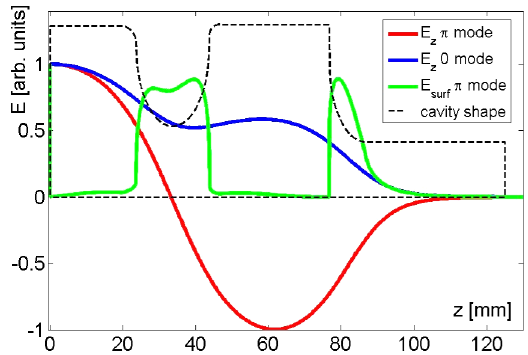
FIG. 2. 2D geometry of the gun with an electric field of the working mode ( π mode) and of the 0-mode.